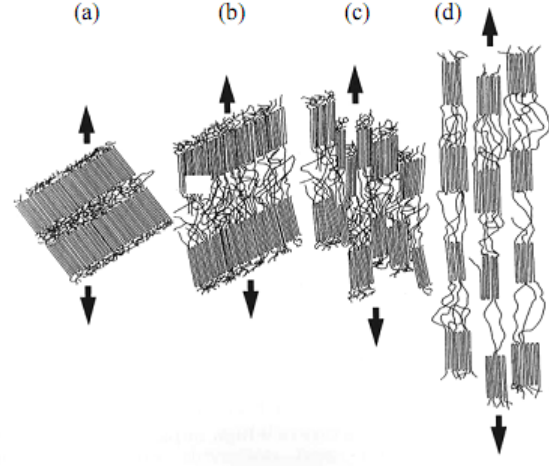
Figure 1. Schematic representation of the deformation process in PP: (a) no deformation, (b) chain motion inside lamellae, (c) lamellae fragmentation and (d) tension alignment (adapted from [20]).